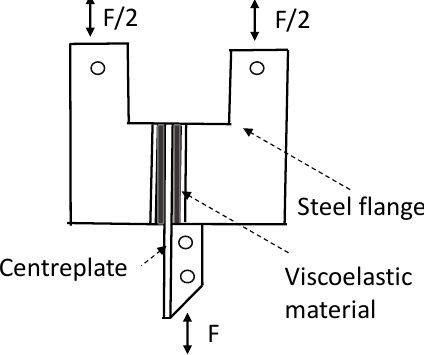
Figure 15. Improvement of Viscous Damper.